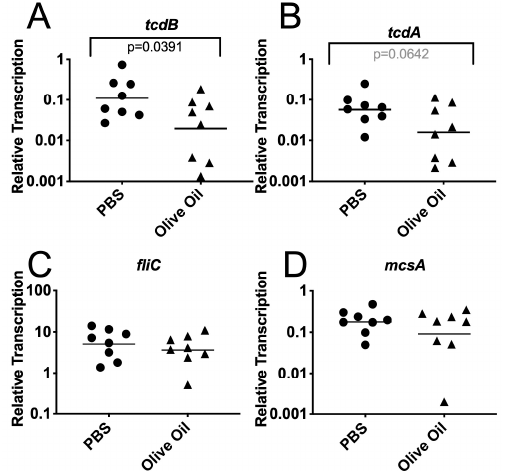
Figure 3. Reduced transcription of tcdB in the epithelium-associated C. difficile cells harvested